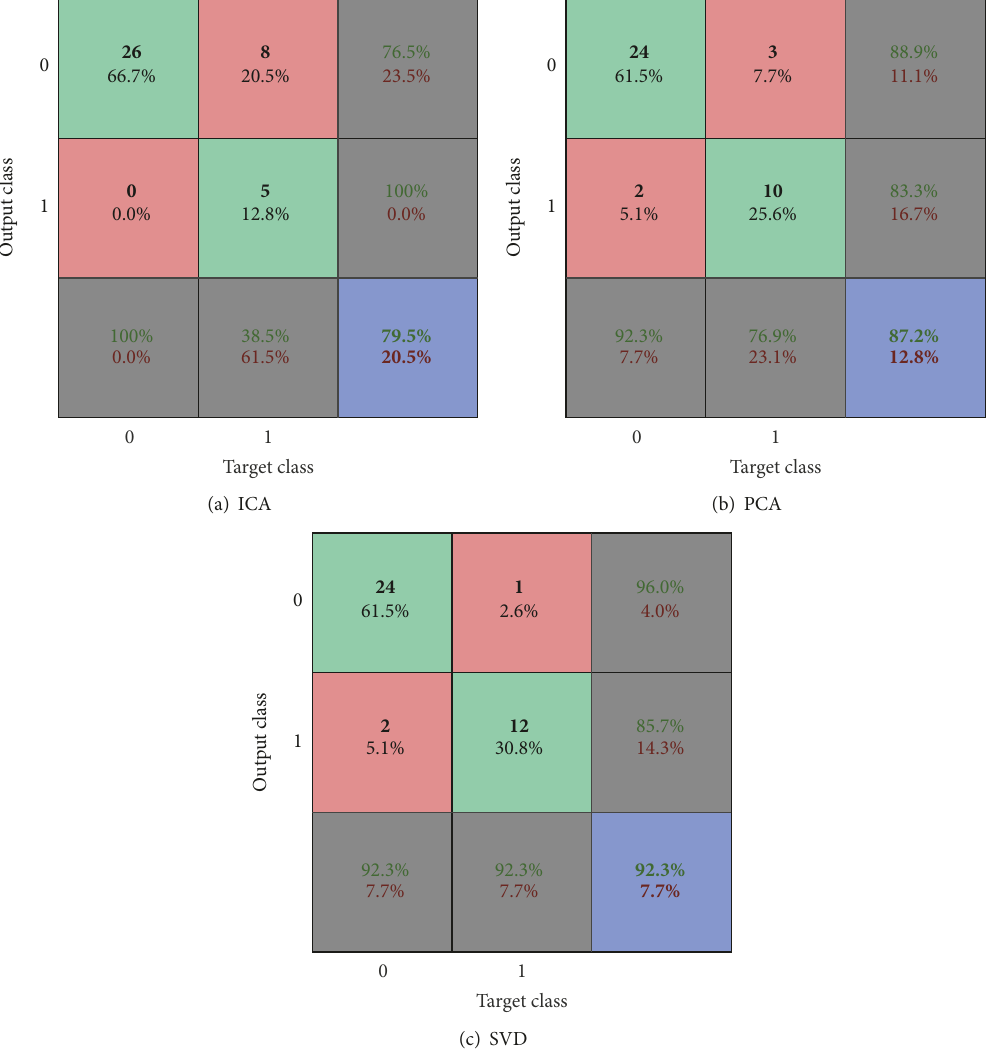
Figure 19: Confusion matrices of classification using the optimized Naive-Bayes for ICA, PCA, and SVD data reduction